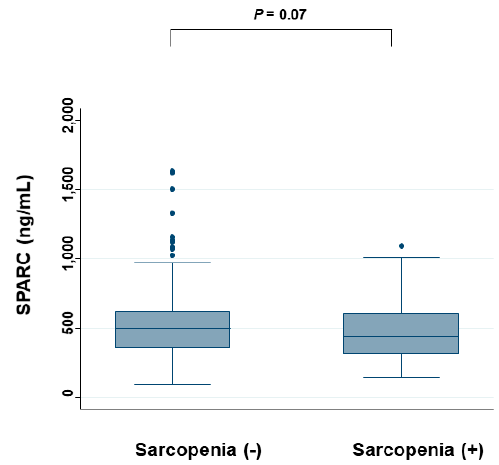
Figure 5. Serum SPARC levels for either the absence or presence of sarcopenia. The SPARC levels are compared between the placebo group and the vitamin D group by the Mann–Whitney test.